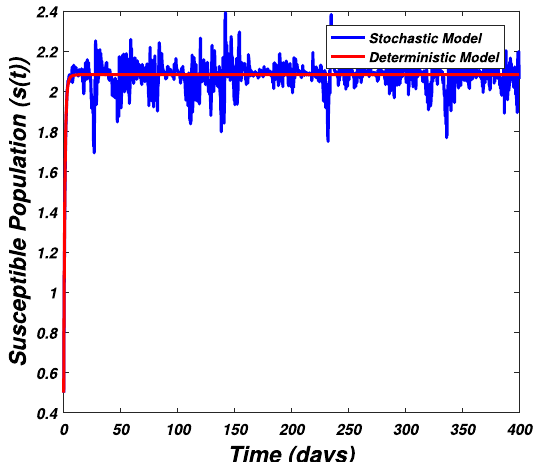
Figure 6. The graph visualizes the temporal dynamics of the epidemic problem described by the model (1) on a large scale for the class of susceptible individuals ( s ( t )) in case of extinction. The parameters value used are taken from S 1 while (0.5, 0.3, 0.2, 0.1) are assumed to be the initial size of